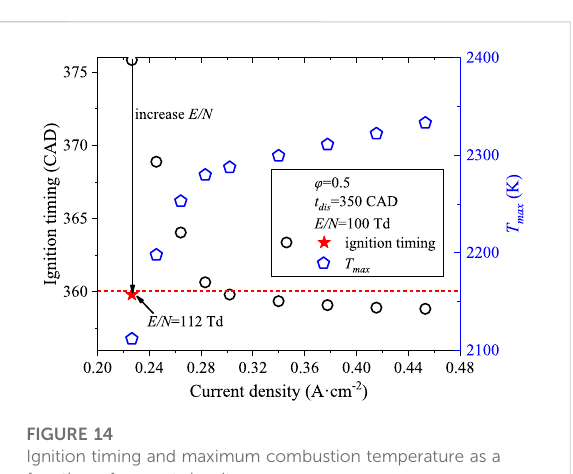
FIGURE 13 Ignition timing and maximum combustion temperature under different E/N .